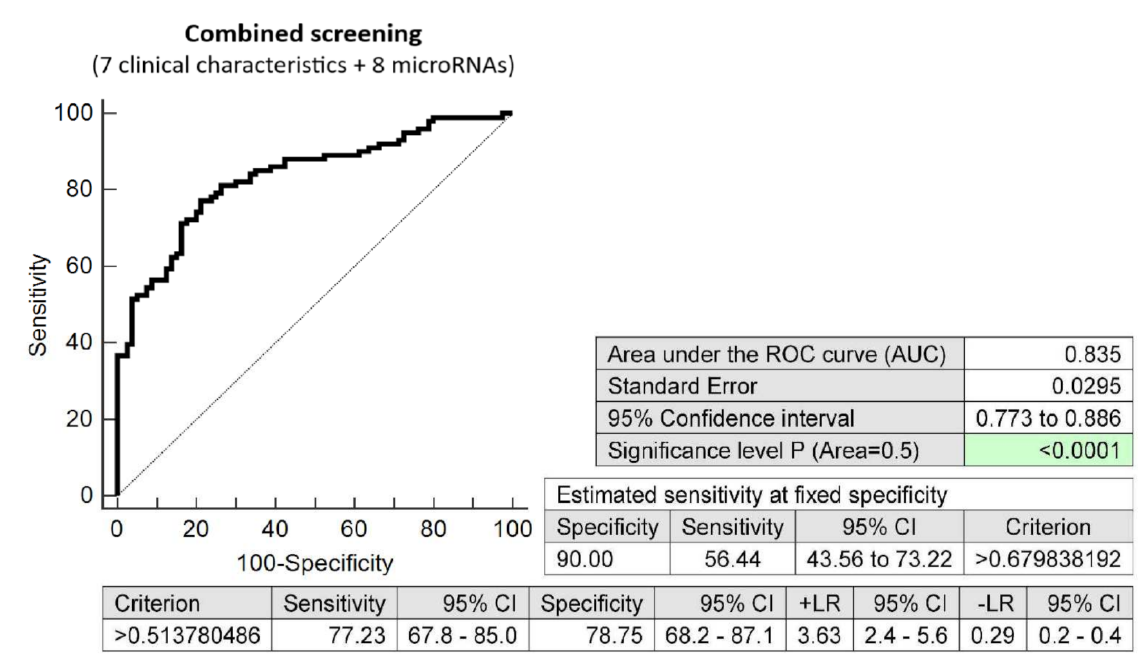
Figure 10. ROC analysis—the combination of 7 clinical characteristics (maternal age and BMI at early stages of gestation, an infertility treatment by assisted reproductive technology, history of miscarriage, the presence of trombophilic gene mutations, positive first-trimester screening for PE and/or FGR by FMF algorithm, and family history of diabetes mellitus in first-degree relatives) and 8 dysregulated microRNA biomarkers (miR-1-3p, miR-20a-5p, miR-20b-5p, miR-100-5p, miR-125b-5p, miR-195-5p, miR-499a-5p, and miR-574-3p). At a 10.0% FPR, 56.44% of pregnancies destinated to develop GDM managed by diet only were identified during the first trimester of gestation. This represents 57 out of 101 pregnancies correctly predicted to develop GDM and 8 out of 80 normal pregnancies predicted false positively to develop GDM.